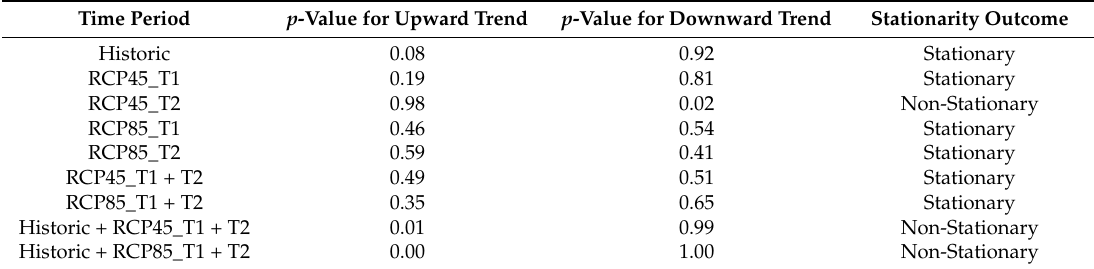
1.00 Stationary 0.01 0.99 Non-Stationary 0.00 1.00 Non-Stationary